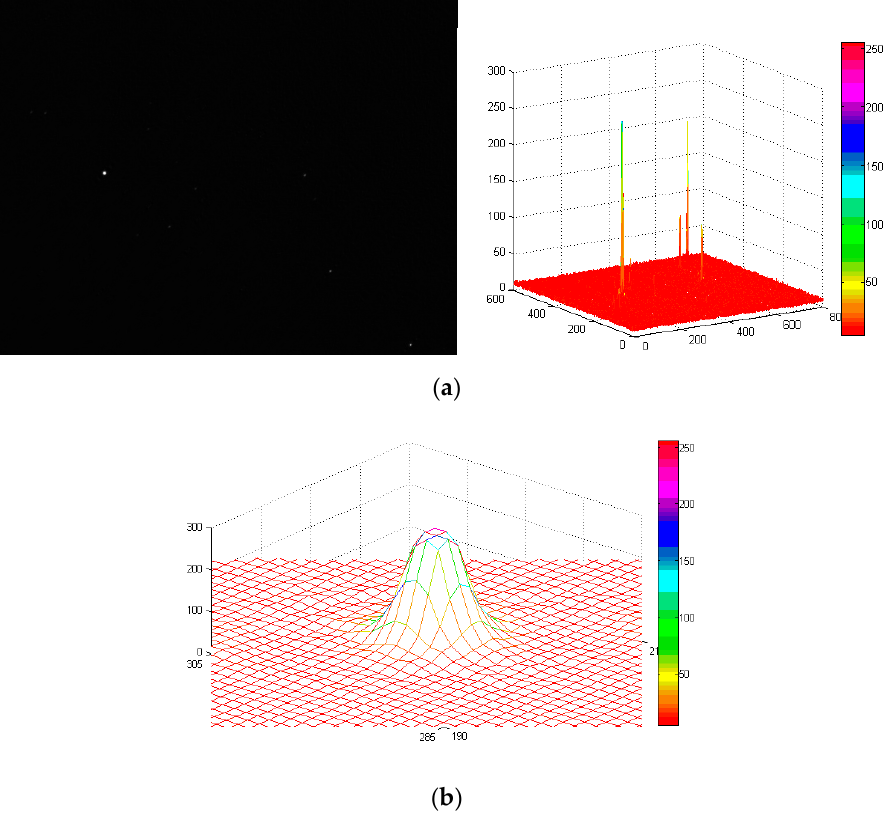
Figure 13. Restored star image of the proposed algorithm under the dynamic condition of w x = w y = 4 ◦ /s. ( a ) Star image restored by the proposed algorithm and its three-dimensional distribution; ( b ) energy distribution of NO.1 star.